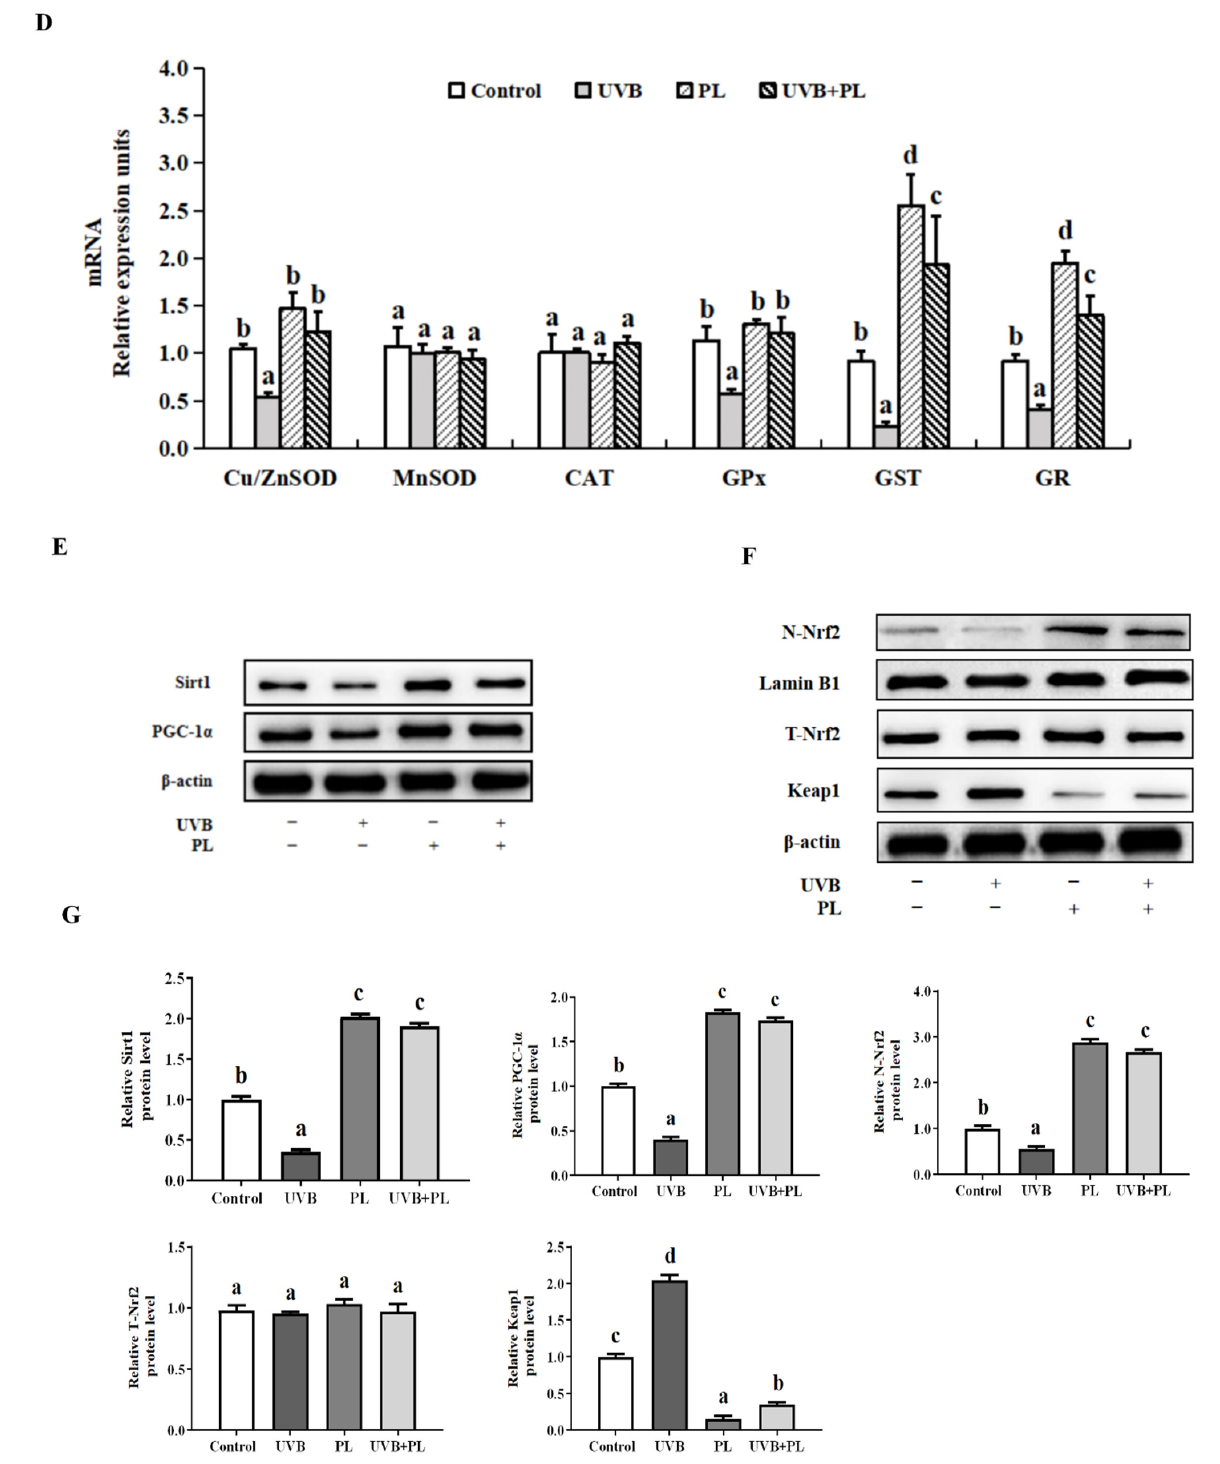
Figure 3. Effects of PL oxidative damage and antioxidant ability in NHDF cells. ( A , B ) The relative ROS level, photomicrographs (100 µm) and bar diagram in NHDF cells. ( C ) MDA and PC contents as well as antioxidant enzymes activity; ( D ) The relative mRNA levels of antioxidant enzymes. ( E – G ) The relative protein levels of Sirt1, PGC-1 α , Nrf2, Keap1. Results are expressed as the mean ± SD ( n = 3). Differences among the variables were assessed using Duncan’s multiple range tests. Values having different letters are significantly different ( p < 0.05).